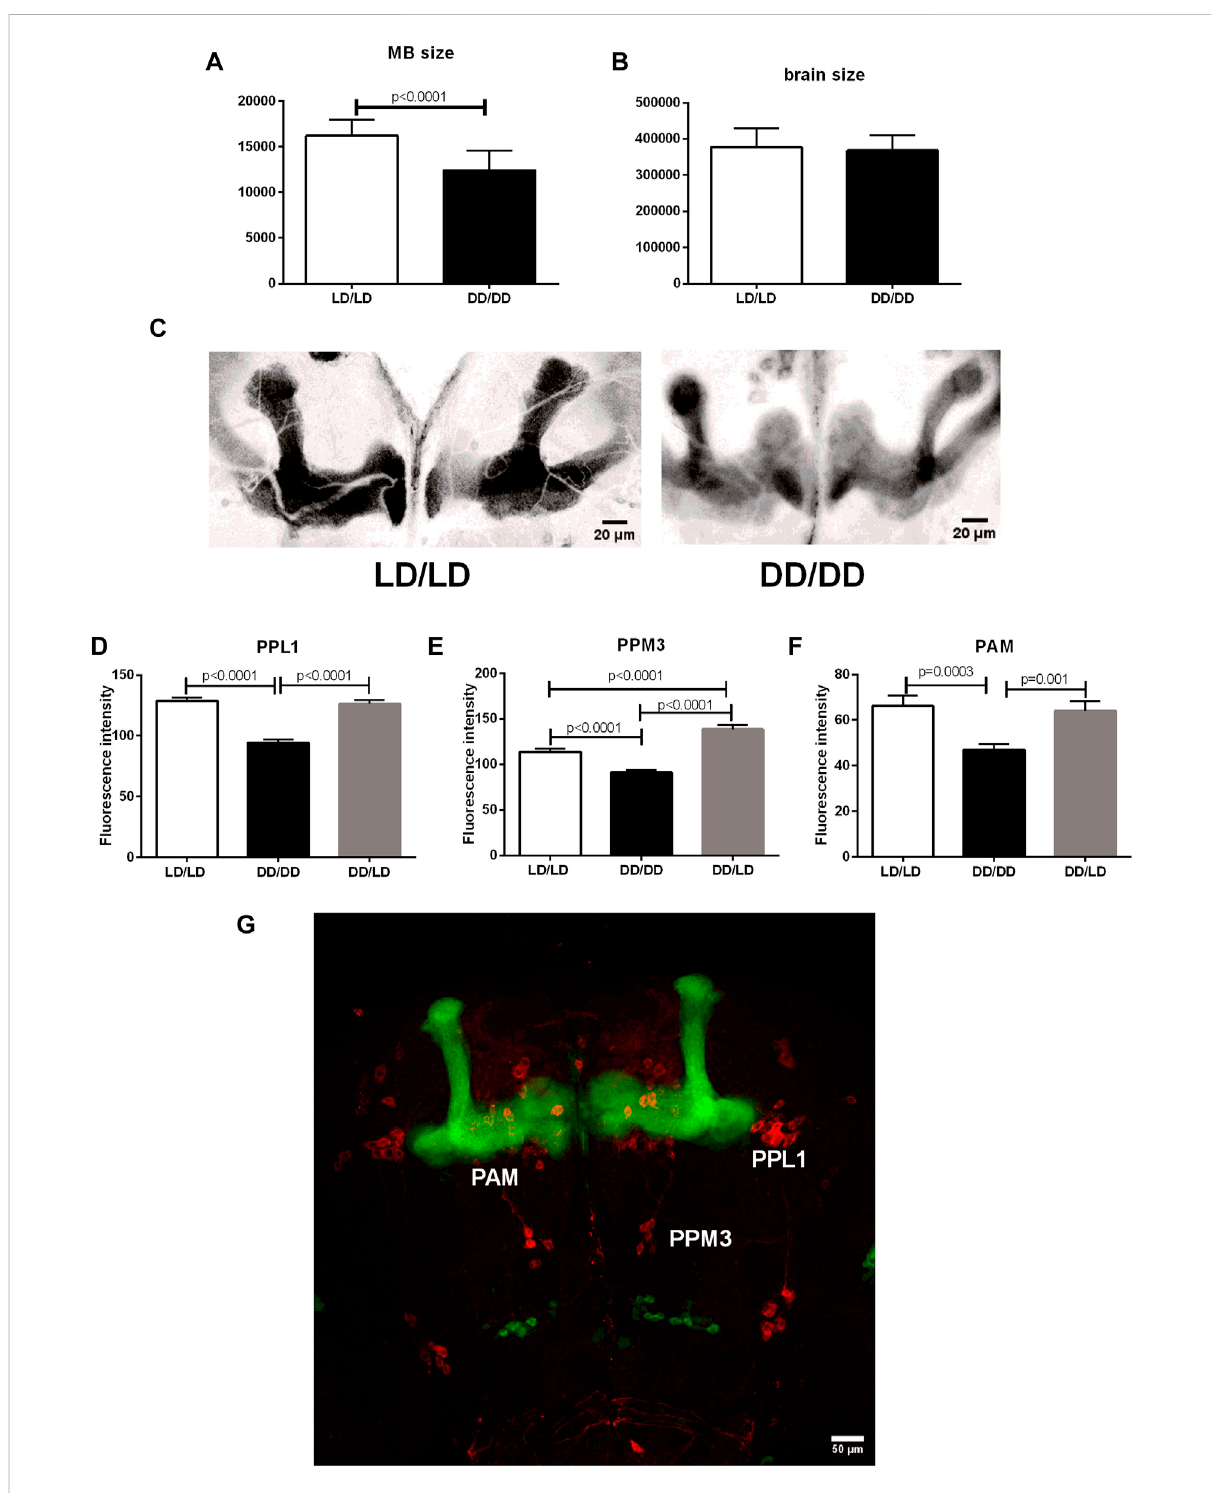
Mushroom bodies development and its dopaminergic input depends on light during early life. (A) The size of MBs is signi fi cantly decreased in fl ies from DD/DD group, while (B) the whole brain size was not changed. (C) Representative confocal images of MB from fl ies developed in LD and DD conditions. Images showed here were modi fi ed: selected area was cropped, 8-bit image was color inverted and contrast was enhanced. (D – G) : Tyrosinehydroxylaseimmuno fl uorescencesignalmeasuredinspeci fi